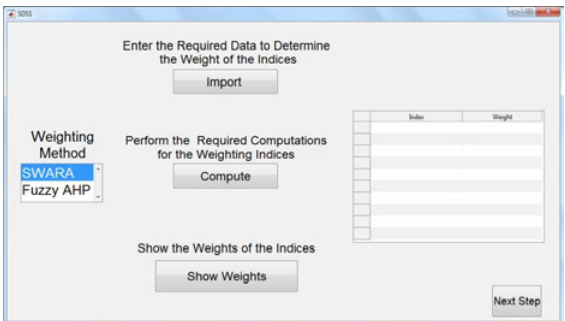
Fig. 5: The user interface of the SDSS; Second step: Calculation of the weight of each index